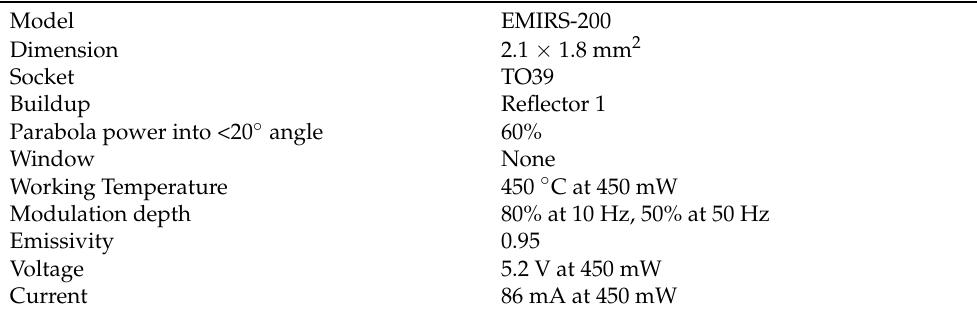
Table 4. Specifications of the IR thermal source.